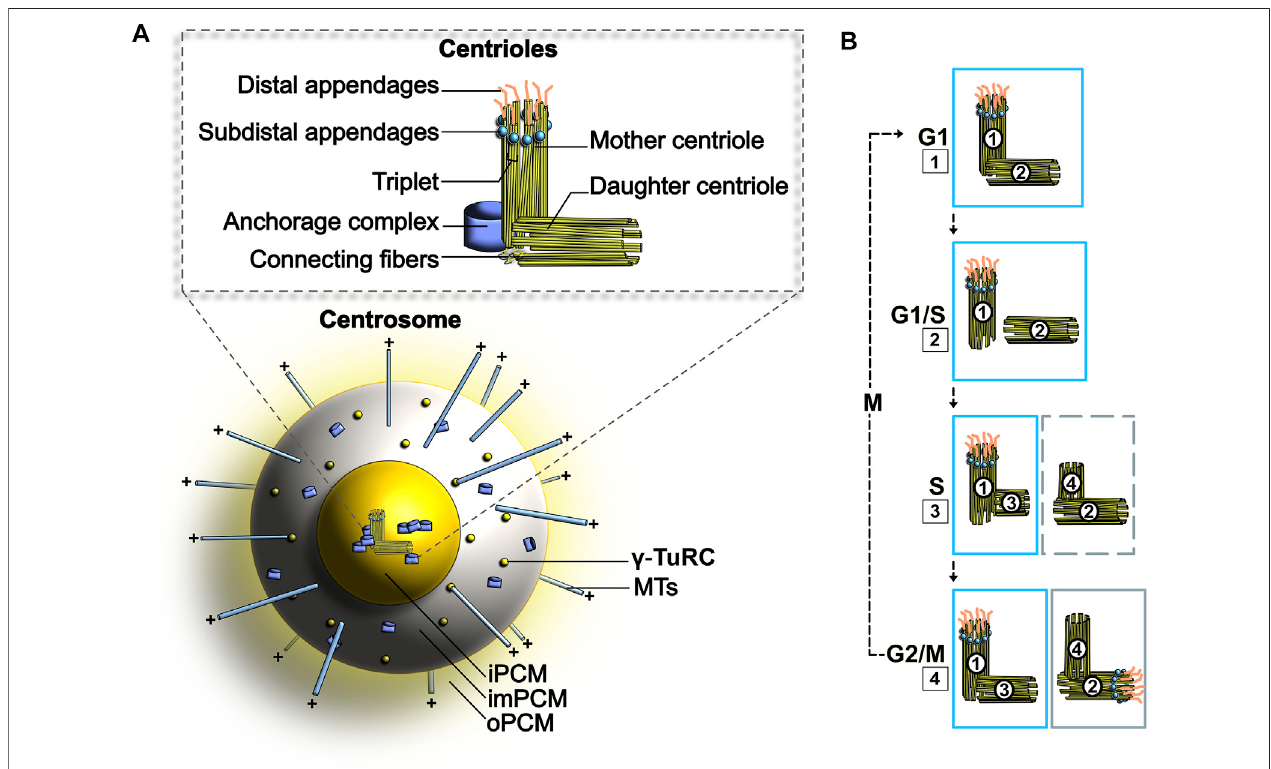
FIGURE 1 | (A) Schematic representation of the centrosome. PCM, Pericentriolar material; iPCM, Inner PCM; imPCM, Intermediate PCM; oPCM, Outer PCM (B) Centrosome duplication cycle. The duplication of centrosomes is termed semi-conservative, as each older centriole will generate a new centriole. 1 – 2 . At the G1/S transition, the two centrioles separate. 3 . In S phase, PCM forms around each parting centriole. 4. Daughter centrioles expand orthogonally and reach opposite poles. See text for more details.